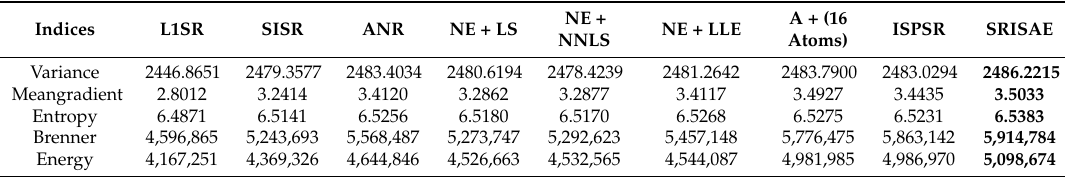
Table 6. Comparison of the average of no-reference image quality evaluation indices of the reconstructed images with different SR